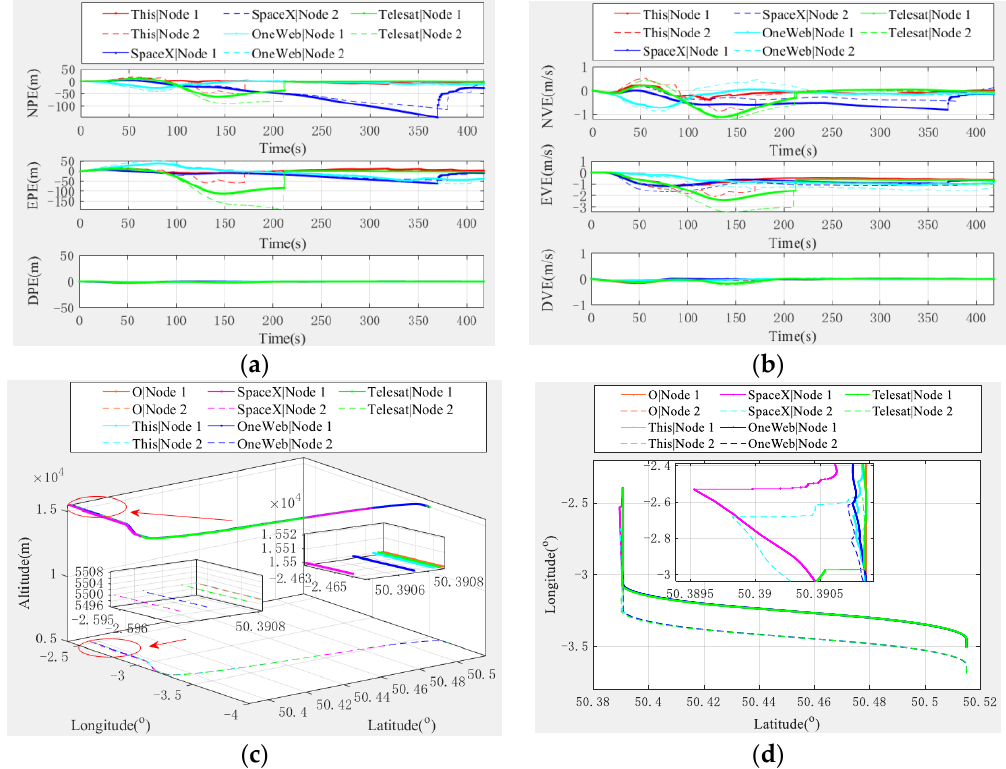
Figure 8. Comparison curve of joint navigation and positioning errors for different LEO systems. ( a ) Position error curve, ( b ) velocity error curve, ( c ) 3D trajectory error curve, and ( d ) 3D projection error curve.